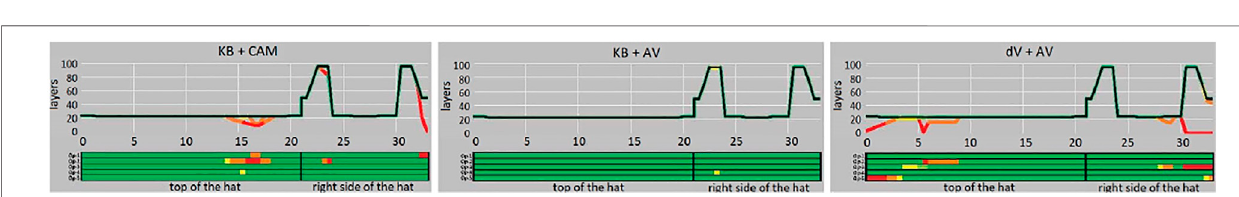
FIGURE 12| Visualization ofthe number of layers successfullycut in all MLI cutting trials. Horizontal axis represents cutting progress (cm), starting at the top of the hatthencontinuingontherightside.Thethinblacklinesindicatethenumberoflayersthatneedtobecut,andthethickcoloredlinesshowthenumberofsuccessfullycut layers for each trial. A single sheet of MLI consists of 23 layers, but there are as many as 95 layers at the corners where the MLI is folded and taped multiple times. The coloredhorizontalbands(oneforeachoperator)underthechartsshowthenumber oflayerscutforeach trial.Colors:darkgreenindicatesalllayerscut;lightgreen indicates one layer uncut; yellow indicates two to three layers uncut; orange indicates 4 – 10 layers uncut; red indicates more than 10 layers uncut.